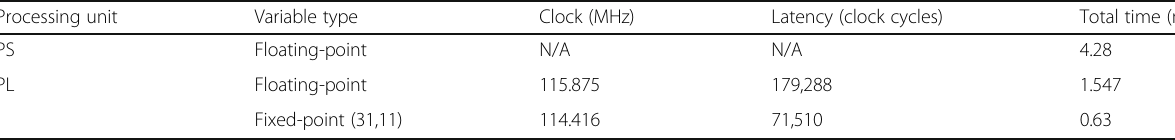
Table 8 OCR hardware implementation performance estimates Processing unit